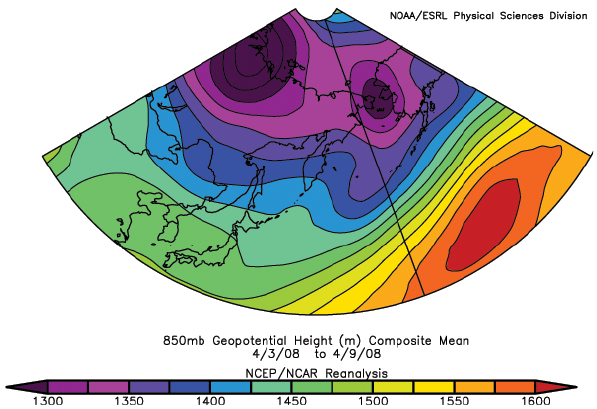
Fig. 14. Average synoptic situation, 28 March–5 April 2008. 850hPa GPZ (m).